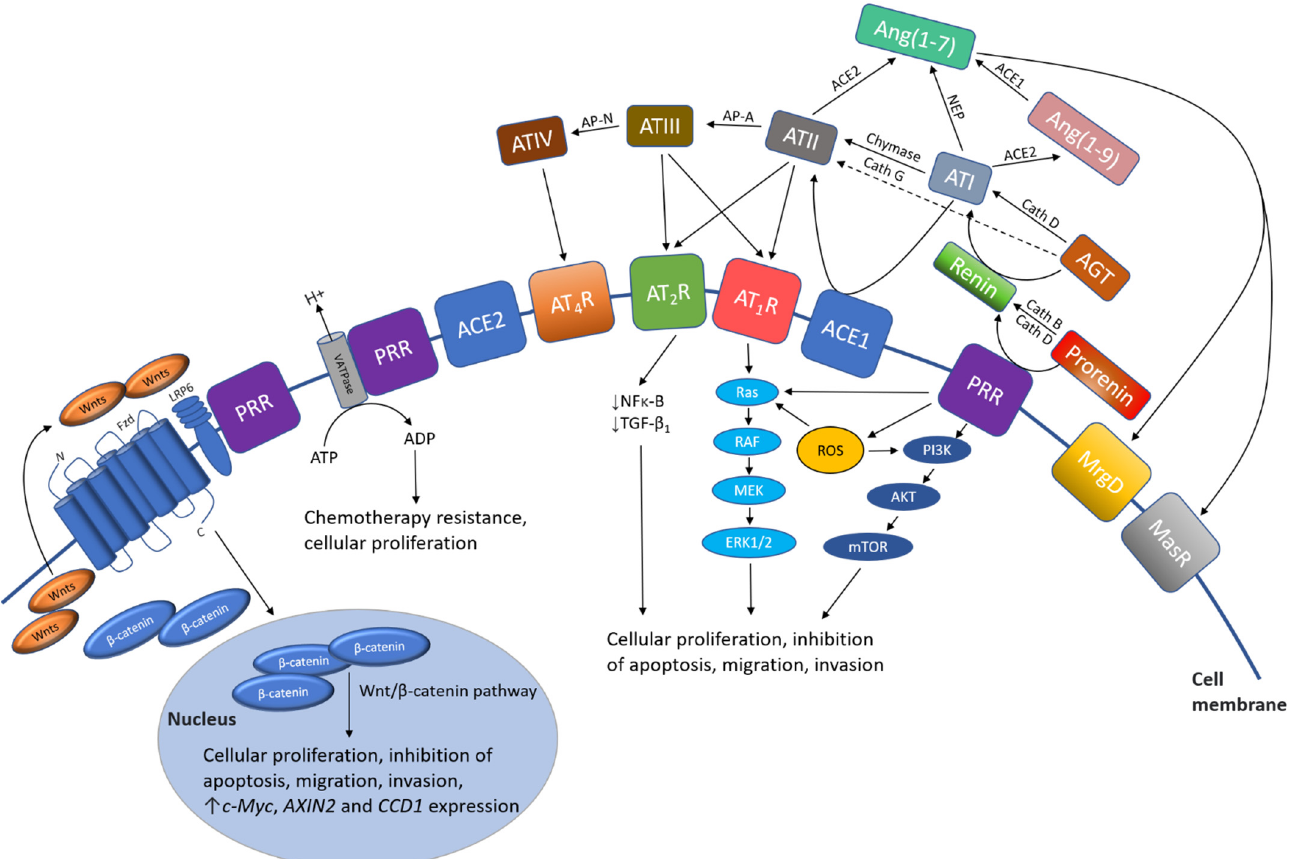
Figure 2. A schema showing the effect of the renin–angiotensin system (RAS) and its convergent signaling pathways on the tumor microenvironment to influence cellular proliferation, invasiveness, and cell survival in cancer develop- ment. The RAS interacts with downstream pathways, such as the Ras/RAF/MEK/ERK (light blue) pathway and the PI3K/AKT/mTOR (dark blue) pathway, and the upstream Wnt/ β -catenin pathway (intermediate blue) that influence cellular proliferation, migration, inhibition of apoptosis, migration, and invasion (see text). PRR, pro-renin receptor; LRP6, low-density lipoprotein receptor-related protein; Fzd, frizzled receptor; Cath G, cathepsin G; Cath B, cathepsin B; Cath D, cathepsin D; ACE1, angiotensin-converting enzyme 1; ACE2, angiotensin-converting enzyme 2; ADP, adenosine diphos- phate; AGT, angiotensinogen; ATP, adenosine triphosphate; Ang(1–7), angiotensin (1–7); Ang(1–9), angiotensin (1–9); AP-A, aminopeptidase-A; NEP, neutral endopeptidase; AP-N, aminopeptidase-N; ATI, angiotensin I; ATII, angiotensin II; ATIII, angiotensin III; ATIV, angiotensin IV; AT 1 R, angiotensin II receptor 1; AT 2 R, angiotensin II receptor 2; AT 4 R, angiotensin II receptor 4; MrgD, Mas-related-G protein coupled receptor; MasR, Mas receptor; mTOR, mammalian target of rapamycin; NF- κ B, nuclear factor kappa B; TGF- β 1 , transforming growth factor- β 1 ; V-ATPase, vacuolar H + -adenosine